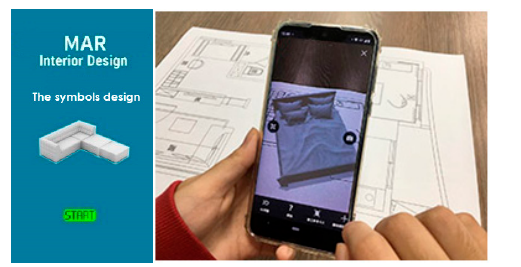
Students: • Learn the di ff erent between 3D dimensions and flat symbols with